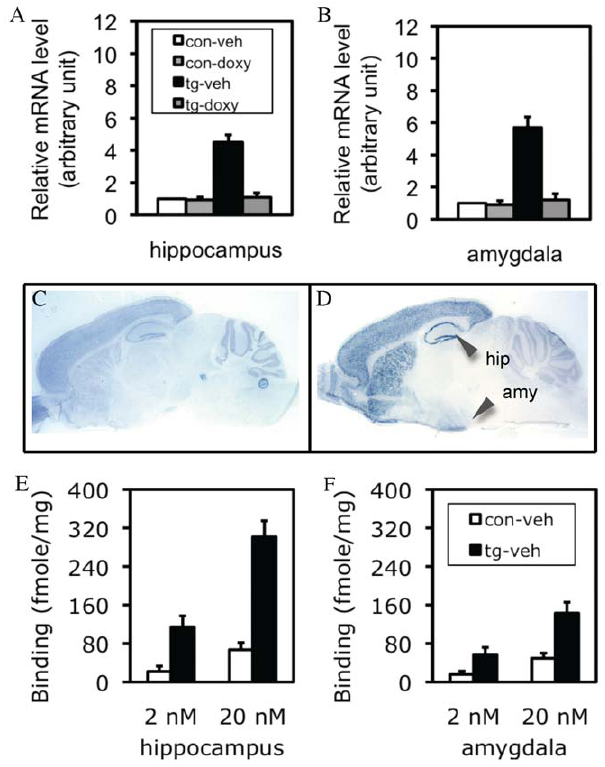
Figure 1. IF-CCKR-2 tg mice. (A and B) Expression level of the total CCKR-2 (endogenous and transgenic) mRNAs in the hippocampus (A) and amygdala (B) detected by real-time RT-PCR. con-veh, control mice- treated with vehicle; con-doxy, control mice-treated with doxy; tg-veh, tg mice-treated with vehicle; tg-doxy: tg mice-treated with doxy. Data are expressed as mean 6 SD. (C and D) Expression pattern of the total CCKR-2 mRNAs detected by in situ hybridization in saggital brain sections. A moderate expression level of CCKR-2 mRNA is observed in the brain of control mice (C), while a higher expression level is observed in all the forebrain regions including the hippocampus (hip) and amygdala (amy) in tg mice (D). (E and F) CCKR binding activity in the hippocampus (E) and amygdala (F) in the presence of a low (2 nM) or a high (20 nM) dose of the ligand. Data are expressed as mean 6 SD.